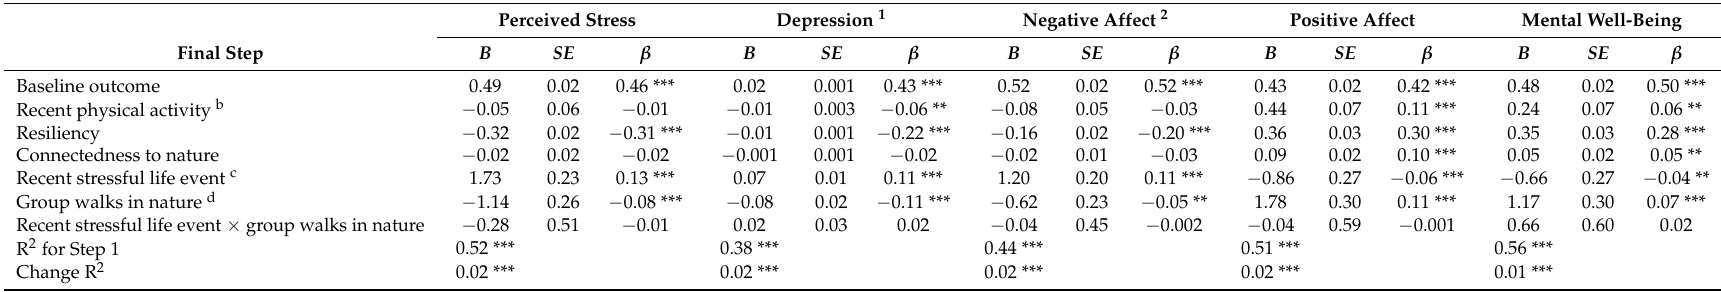
Table 3. Moderation results assessing group walks in nature, recent stressful life events, and the interaction term on perceived stress, depression, negative affect, positive affect, and mental wellbeing. Main sample ( n = 1506 a ).